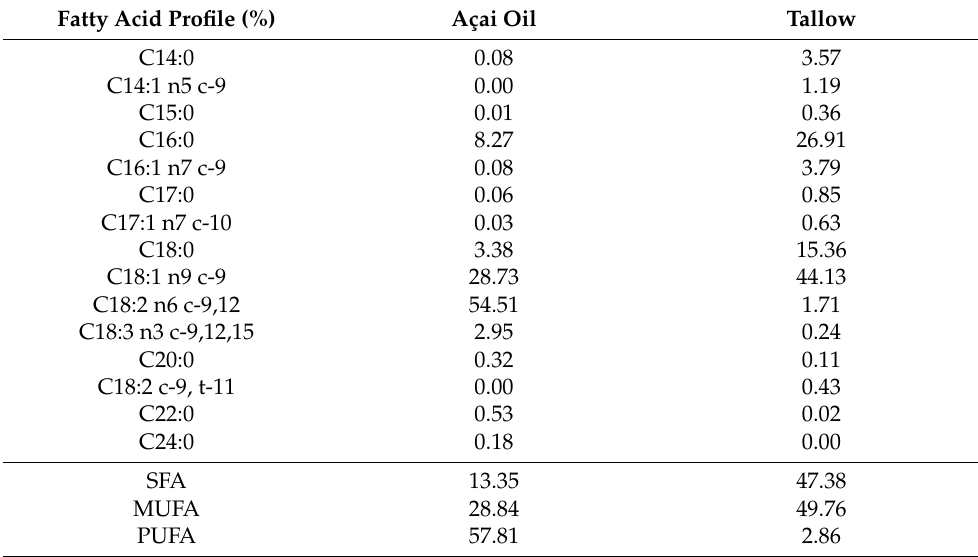
Table 5. Basic composition of the substrates used in the